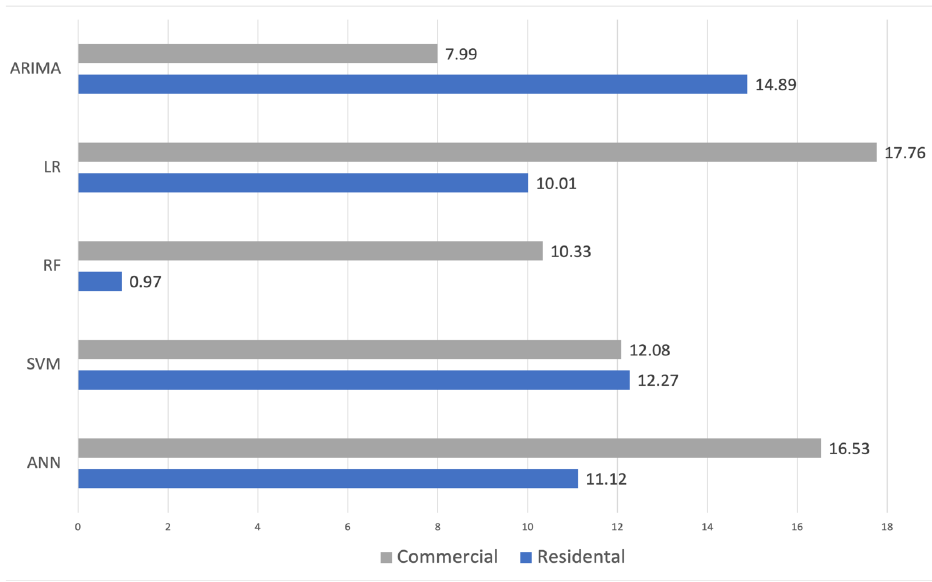
Figure 6. Average performance values of energy prediction for predicting different buildings.